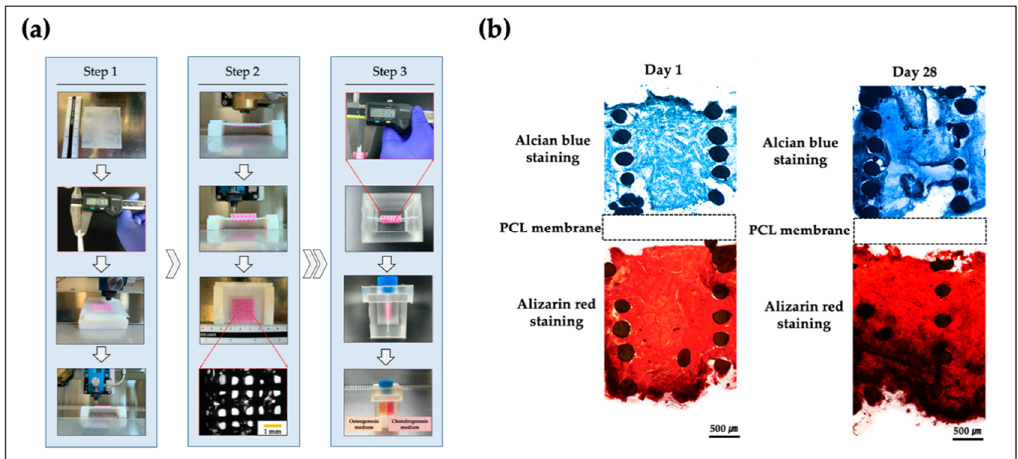
Figure 5. Fabrication process and histopathologic results of osteochondral scaffold [173]. ( a ) The fabrication process of bipartite scaffold using a 3D bioprinting system; ( b ) histological results at day 1 and